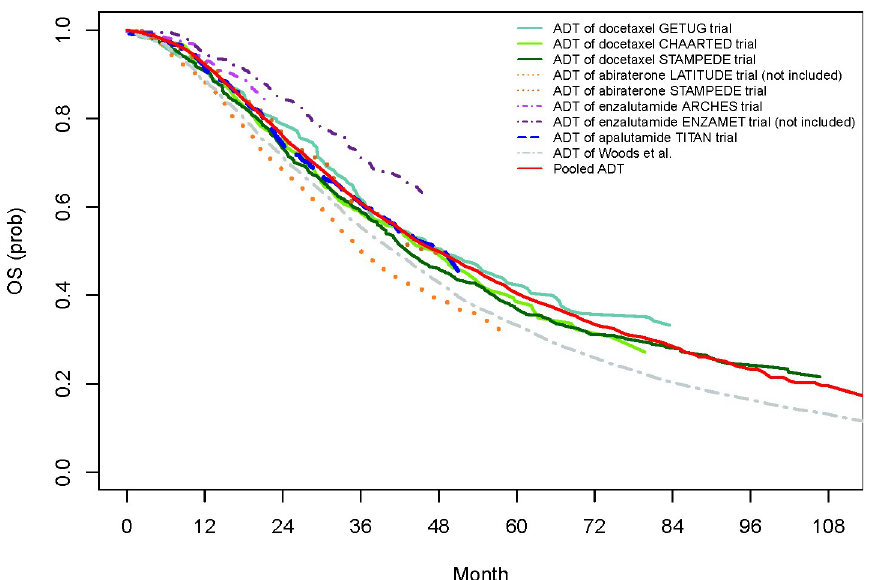
Fig 1. Pooled OS curve for ADT and re-created Kaplan Meier OS estimates for the ADT arms of each trial. Abi, abiraterone; ADT, androgen deprivation therapy; Apa, apalutamide; Doc, docetaxel; Enza, enzalutamide; OS, overall survival. Comment: ENZAMET and LATITUDE were not included in the meta-analysis.